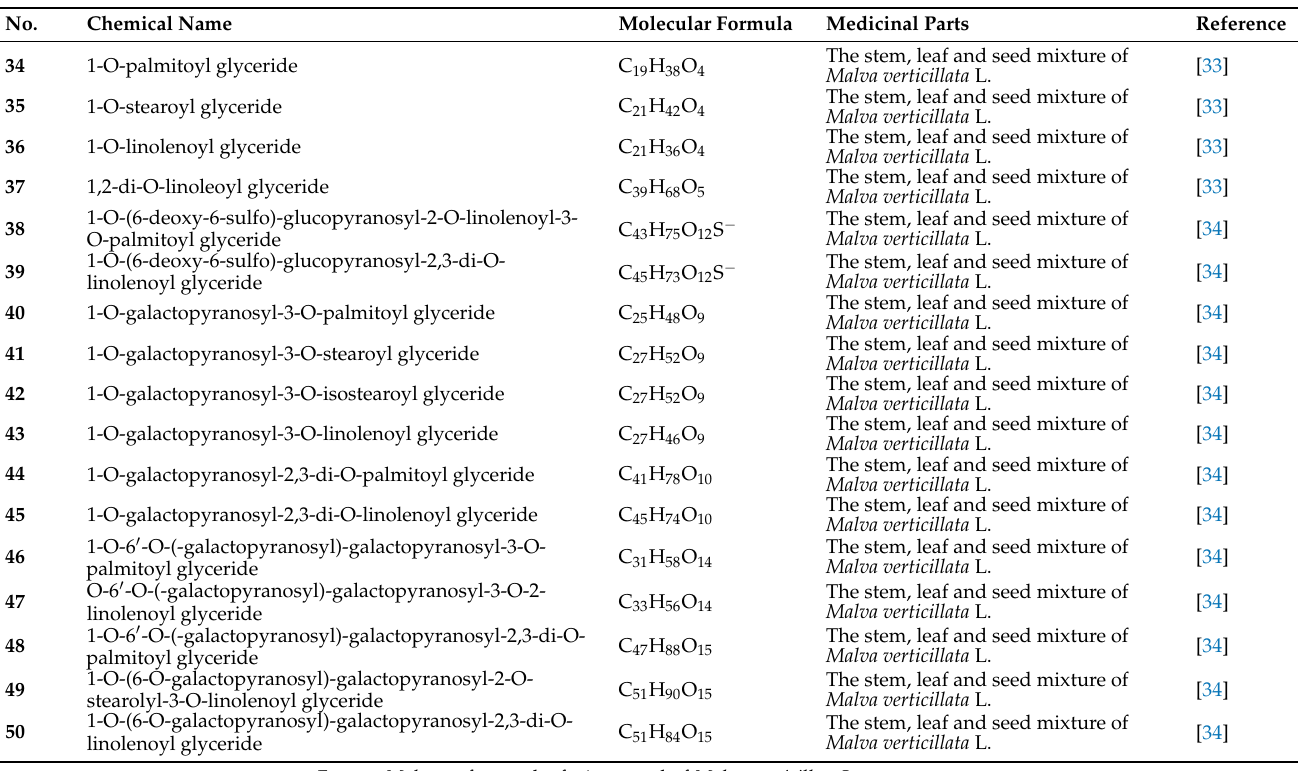
Table 4. The Glycerides identified from Fructus Malvae .